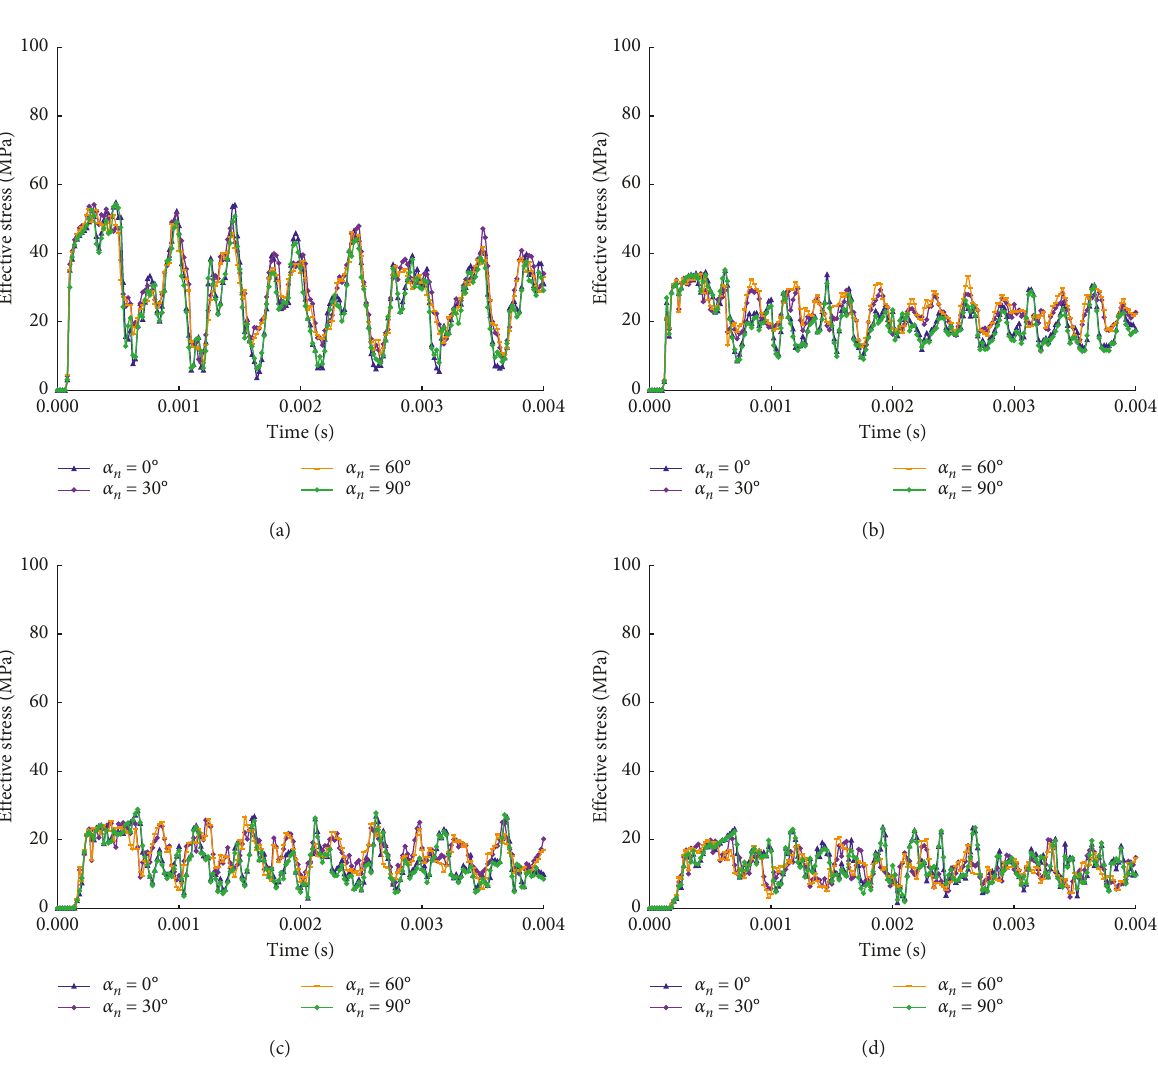
� 8. (b) D � 12. (c) D � 16. (d) D m / r b m / r b m / r b m /